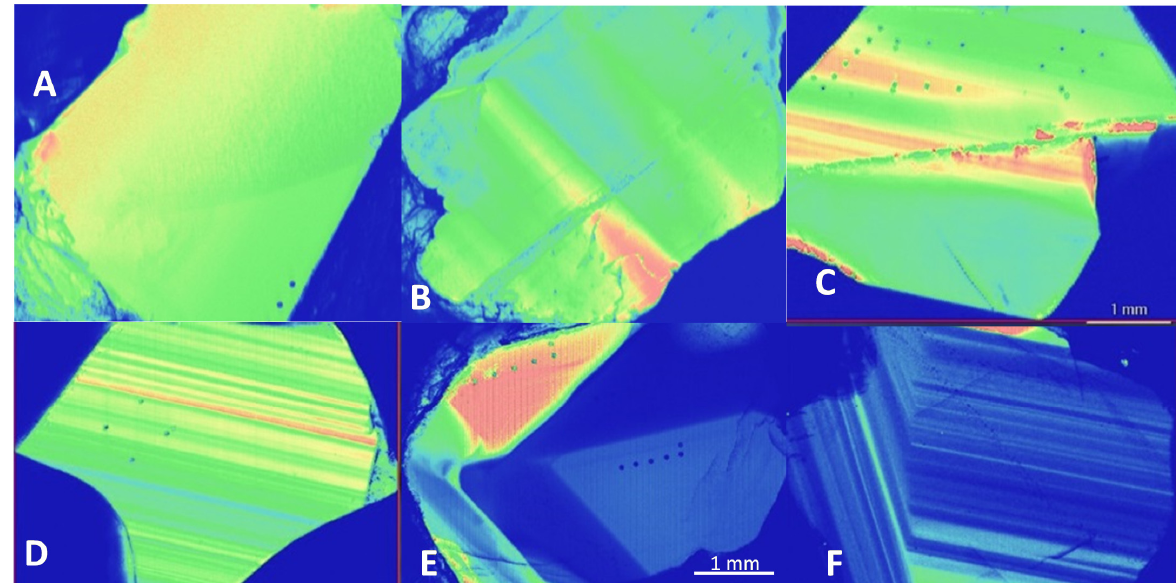
Figure 20. Representative PL maps showing Cr distribution in Burmese sapphires showing ( A ) the near absence of spatial variations in Cr concentrations, ( B , C ) growth zoning with diffuse boundaries, and ( D – F ) growth zoning with sharp boundaries arranged in hexagonal patterns.